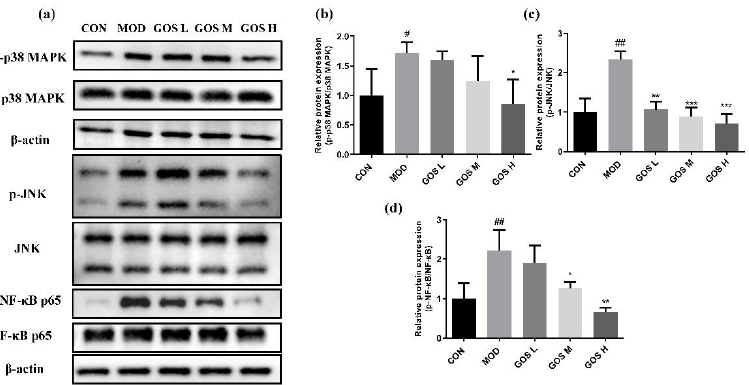
Figure 9. Effects of GOS on the NF- κB and MAPK pathways in mouse liver. ( a ) Western blot images of the NF- κB and MAPK pathways in mouse liver ( n = 3, means ± SD). ( b ) Phosphorylated protein expression levels of p38 MAPK ( n = 3, means ± SD). ( c ) Phosphorylated protein expression levels of JNK ( n = 3, means ± SD). ( d ) Phosphorylated protein expression levels of NF- κB p65 ( n = 3, means ± SD). Notes: Compared with the MOD group, * p < 0.05, ** p < 0.01, and *** p < 0.001; compared with the CON group, # p < 0.05, ## p < 0.01.